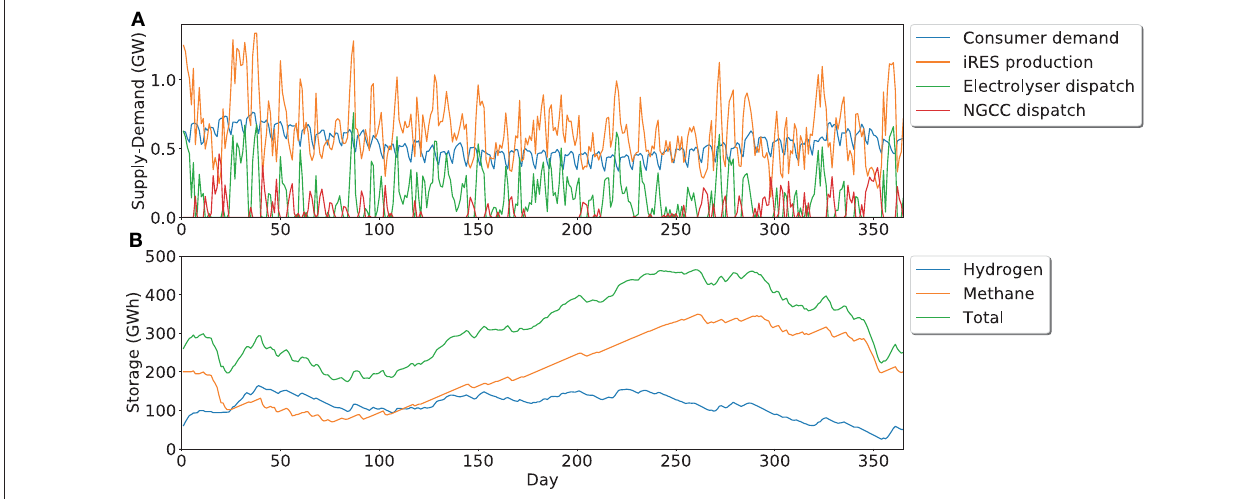
FIGURE 7 | (A) Daily fluctuations in the projected demand and supply for the P-M-P system (shown as lines “Consumer demand” and “iRES production”) using 2015 meteorological data, and the resulting dispatch capacity required for the electrolyser and NGCC (GW). (B) Hydrogen and methane storage requirements (GWh) and the two curves combined. Day 1 as January first. The small peak in hydrogen production around day 45 is represents a peak in wind power production in February